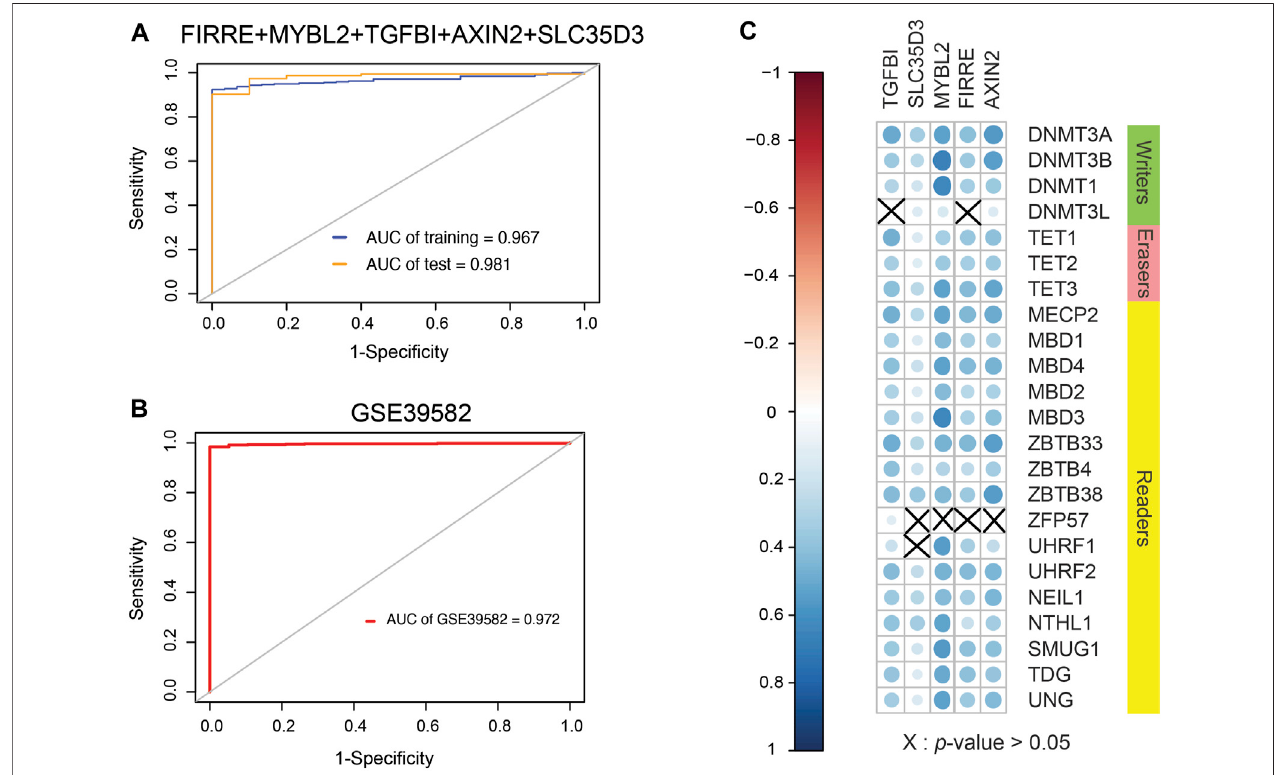
FIGURE 8 | Clinical performance assessment of signature and Spearman correlation coef fi cient between them and 5mC regulators. (A) ROC curves of fi ve-gene signature involving FIRRE, MYBL2, TGFBI, AXIN2, and SLC35D3 (AUC of training set (cid:1) 0.967, AUC of test set (cid:1) 0.987). (B) ROC curves of diagnostic signature in GSE39582, which includes 19 normal cohorts and 566 cancer cohorts (AUC of GSE39582 (cid:1) 0.972). (C) SCC between them and 5mC regulators. Size of nodes is inversely proportional to p- value. Erasers are related to genes from signature, and a part of writers and readers are related to these genes.